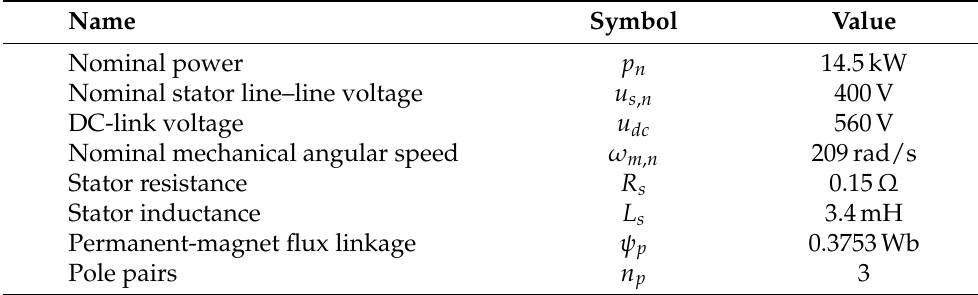
Table 1. Parameters of the PMSG under test.